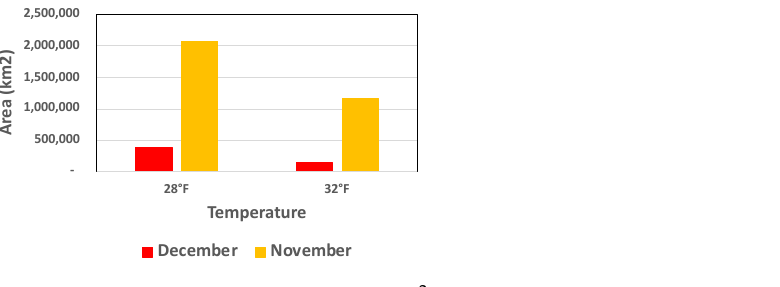
Figure 3. Quantification of the areas (km 2 ) in Figure 2 for 32 °F and 28 °F note: 32 °F = 0 °C, 28 °F = −2. 2 °C).